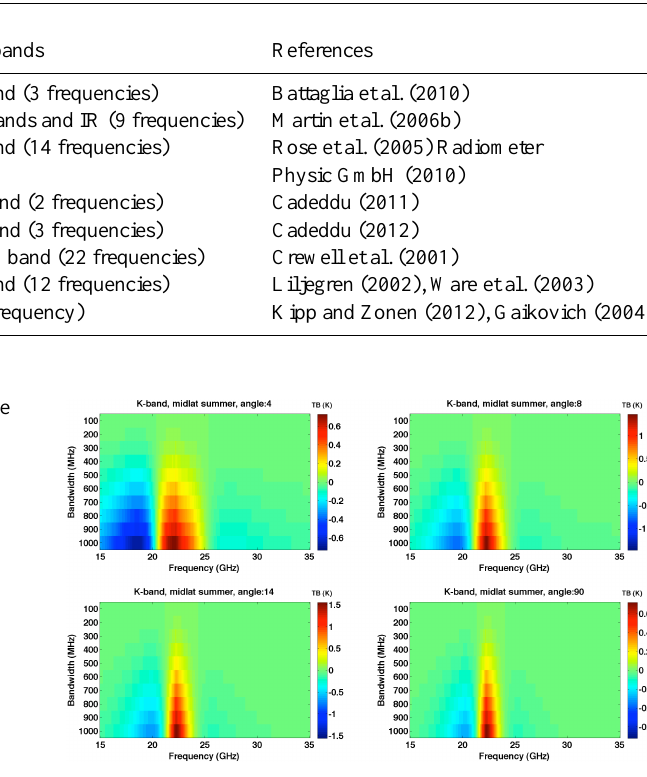
Fig. 4. The errors associated to the channel bandwidth effect in TB Figure 4. The errors associated to the channel bandwidth effect in TB differences for K-band 5 differences for K-band frequencies using the mid-latitude summer frequencies using the mid-latitude summer atmospheric profile. The TB differences are 6 atmospheric profile. The TB differences are defined as the TB cal- defined as the TB calculated from a forward model without bandwidth minus the TB 7 culated from a forward model without bandwidth minus the TB cal- calculated from a forward model with bandwidth. 8 culated from a forward model with